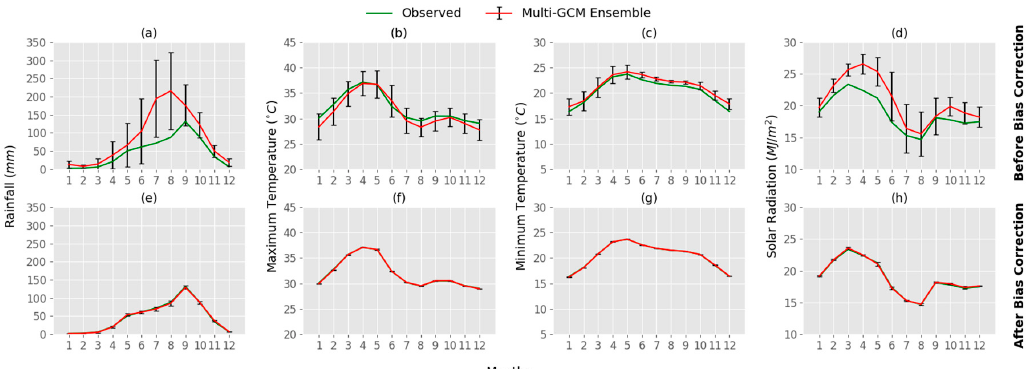
Figure 5. Comparison of observed and multi-GCM ensemble (error bars represent variability among the five GCMs) time series of 1990s for before and after bias correction of ( a ) rainfall, ( b ) maximum temperature, ( c ) minimum temperature, and ( d ) solar radiation in AEZ 3.